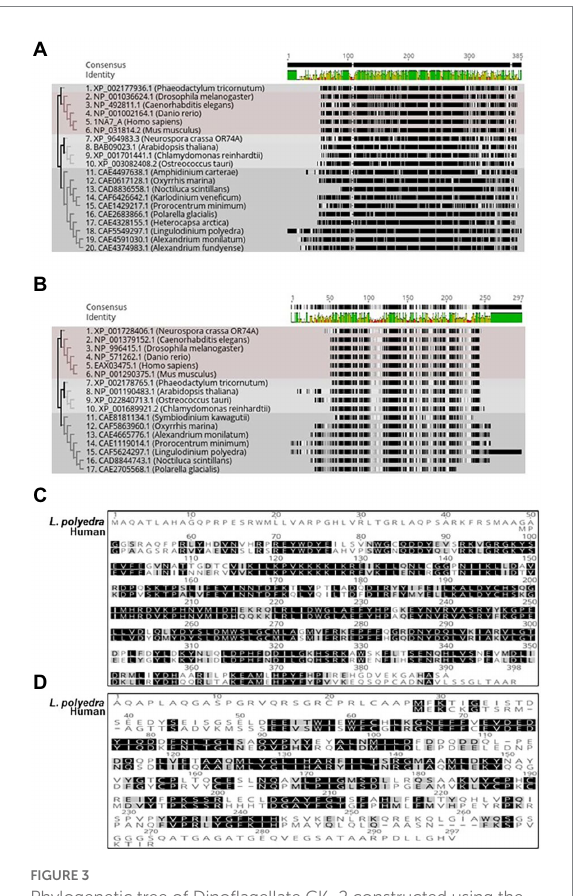
FIGURE 3 Phylogenetic tree of Dinoflagellate CK_2 constructed using the ML method embedded in RaXML software plugin in the Geneious Prime 2022.2.2 version software. Accession numbers of the sequences used to construct the tree are mentioned at the beginning of the organism’s name. (A) CK-2 alpha domain. (B) CK-2 beta domain. (C) Multiple sequence alignment of Lingulodinium polyedra CK2 alpha with human CK2 alpha using the clustalW extension in geneious prime software. (D) Multiple sequence alignment of Lingulodinium polyedra CK2 beta with human CK2 beta using the clustalW extension in geneious prime